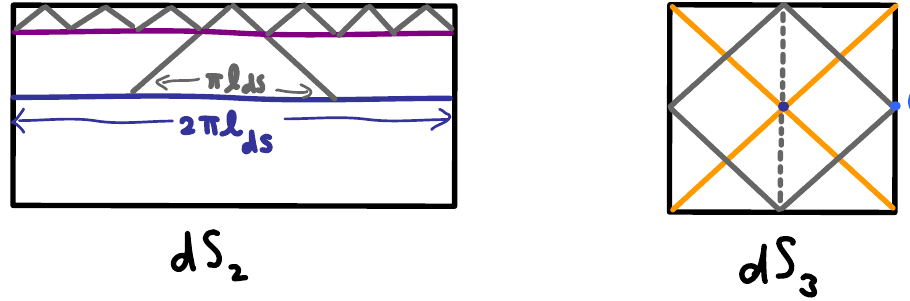
Figure 4 . The left panel contains the dS 2 Penrose diagram; the vertical sides are identi(cid:12)ed. The dark blue line at (cid:28) = 0 corresponds to the central dot (a circle of radius ‘ dS ) in the dS 3 diagram from (cid:12)gure 2, reproduced here on the right. This full circle of size 2 (cid:25)‘ dS is the horizon for the observer O on the far right, causally connected to it through the dS 3 bulk. Within the global dS 2 geometry, the segments with extremal area (cid:25)‘ dS between the end points are the largest for which the endpoints can communicate, as derived in the text. On a late-time slice, indicated in purple, we show a string of causal segments whose extremal area is (cid:25)‘ dS and entanglement entropy is (cid:25)c= 6. sectors in the dS/dS duality leads to the same entanglement entropy and Renyi entropies as in (6.1). This agrees precisely with the gravitational prediction (4.13) given